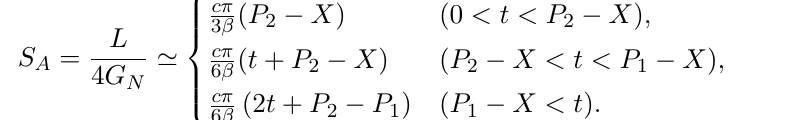
log(2 r ) as we are interested in the large r /r ∞ + 2